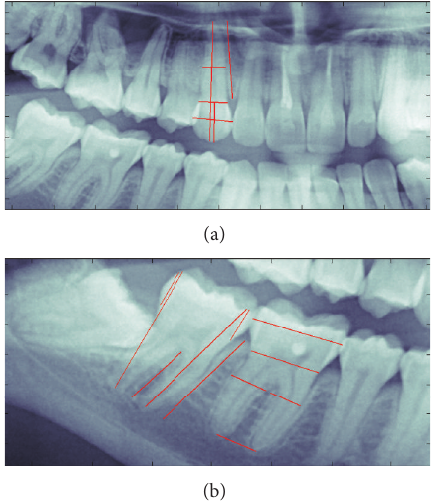
Figure 1: (a) Measures and landmarks on a monoradicular tooth (1.3). (b) Measures and landmarks on multiradicular teeth (4.6, 4.7).